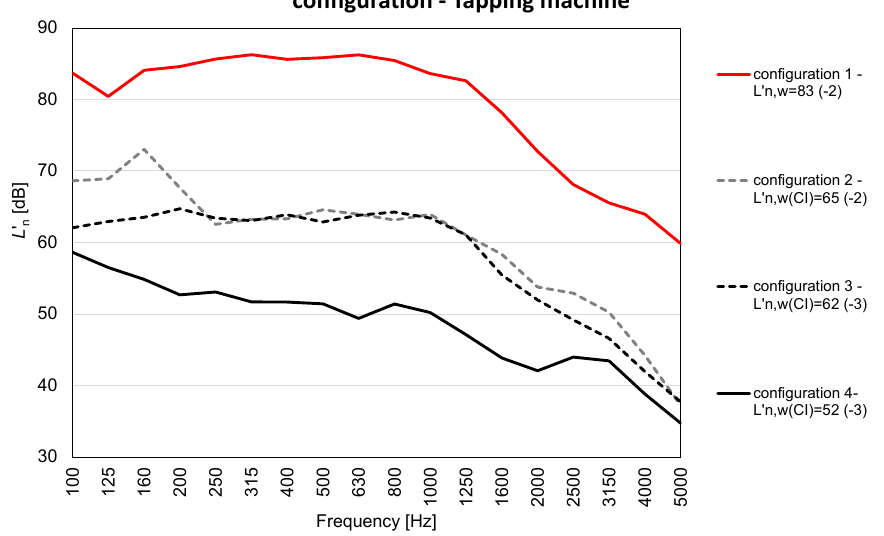
Figure 10. Impact sound pressure level for CLT floors (configurations 1, 2, 3, and 4). Source: tapping machine.